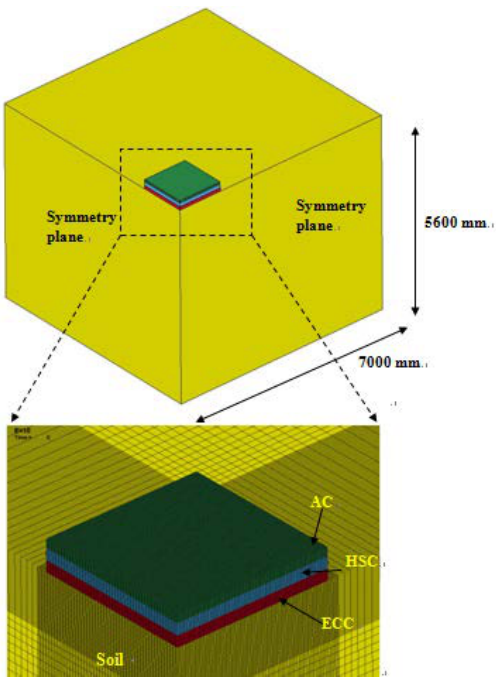
Figure 10. Finite element model of the multi-layer pavement slab.